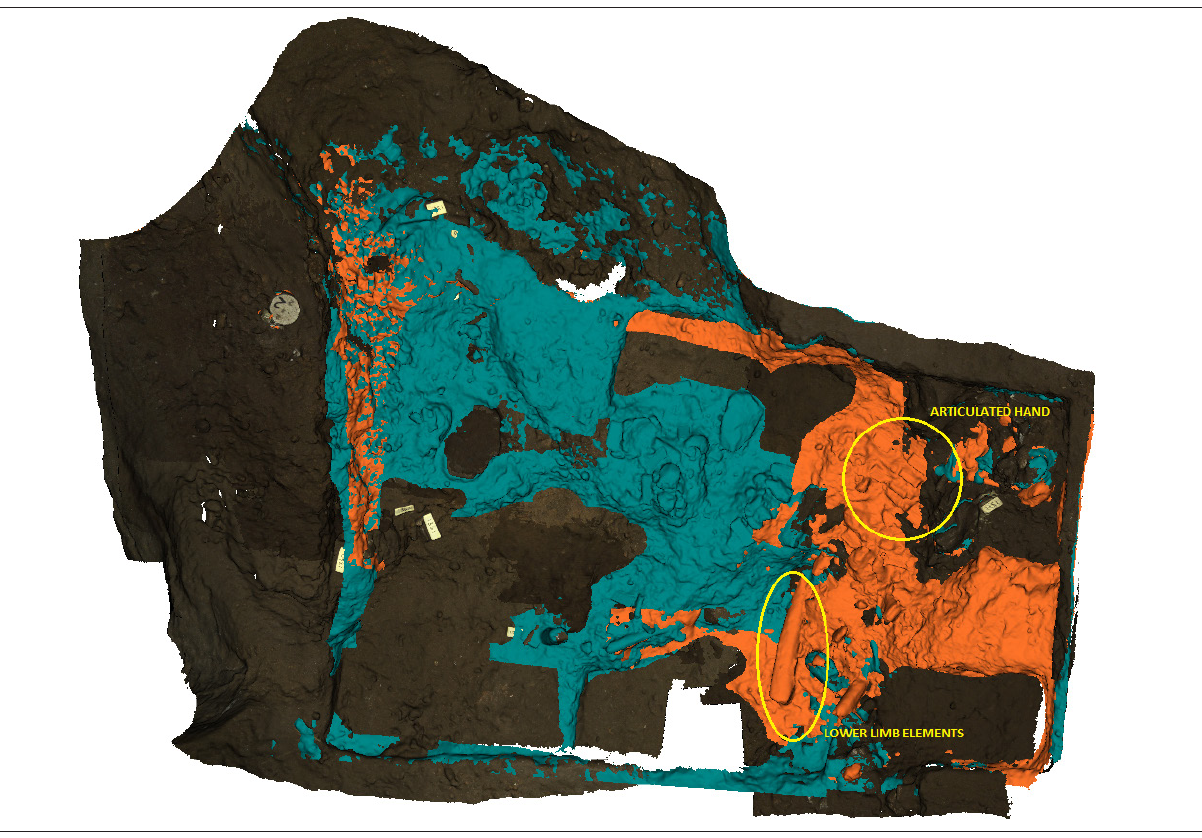
As access to the cave was limited (by the 180-mm diameter chute), conventional archaeological survey equipment could not be used during excavation. Instead, 3D high-resolution scans were used to record the position of each bone as uncovered. This image is made up of scans taken at four separate stages during the excavation process. The brown base layers show the limits of the excavation pit, whilst the blue and orange layers show the fossils being excavated on two separate days in March 2014. The articulated elements of a fossilised hand and part of a lower limb can clearly be seen. The scans were produced in the cave with an Artec Eva photogrammetric scanner and aligned and assembled in the lab using Artec Studio 3 South African Journal of Science http://www.sajs.co.za